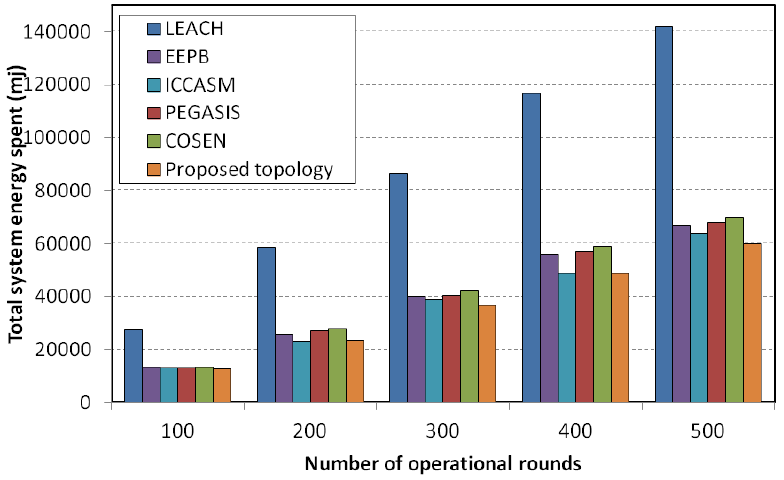
Figure 22. Total energy consumption comparison among LEACH, PEGASIS, COSEN, EEPB, ICCASM and the proposed